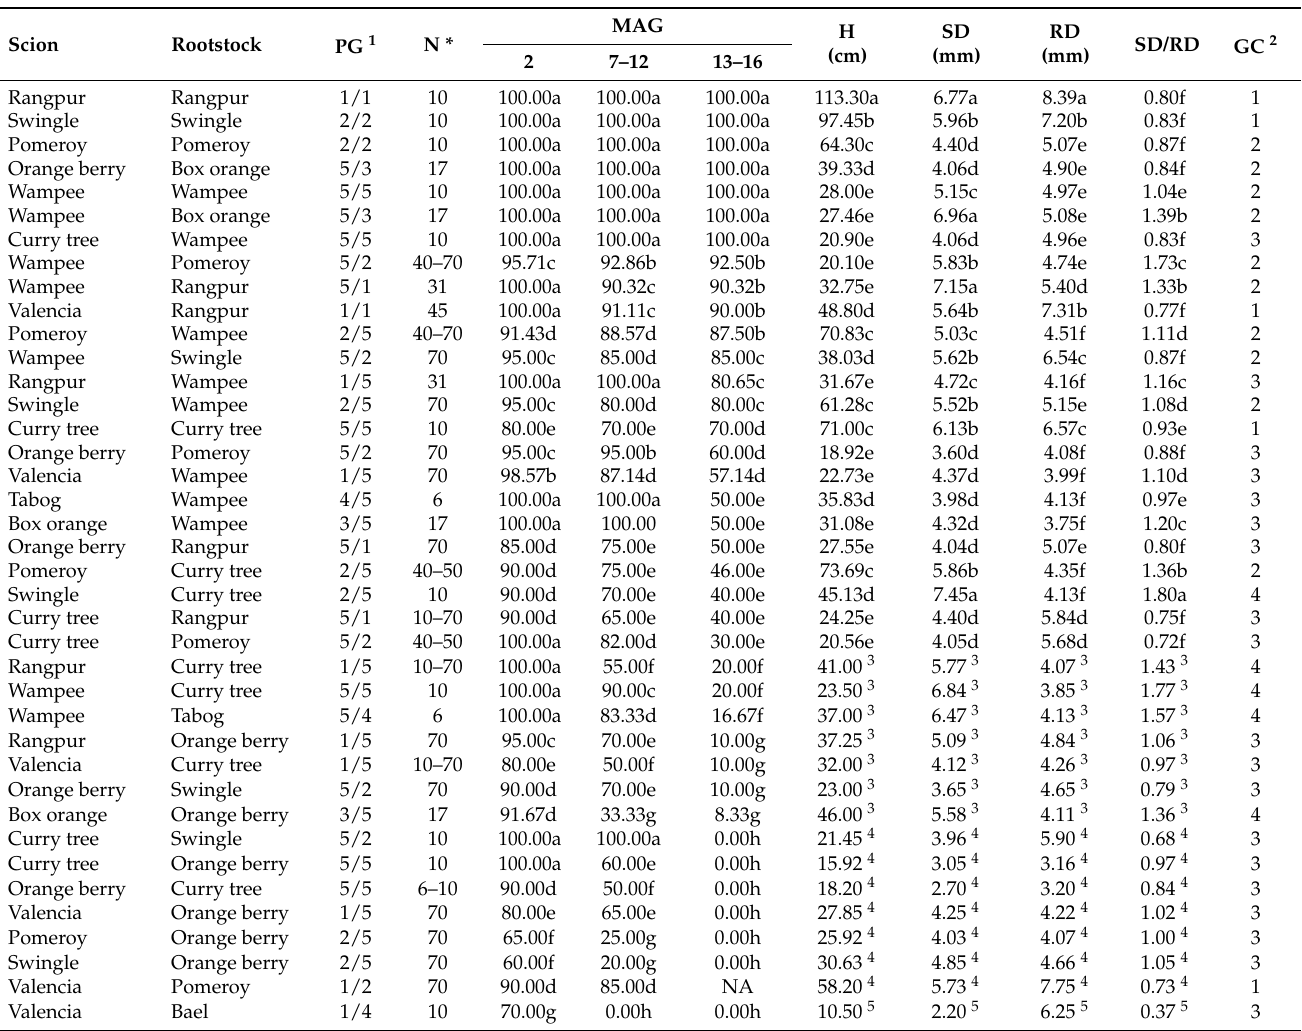
Table 3. Graft-take (%) of the second group of scion/rootstock combinations within different Auran- tioideae phylogenetic groups (PGs) at 2, 7–12, and 13–16 months after grafting (MAG), mean values of plant height (H), scion stem diameter (SD), rootstock stem diameter (RD), scion and rootstock stem diameter relation (SD/RD) at 13–16 MAG, and graft compatibility group